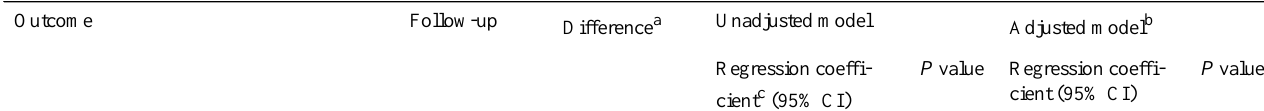
Table 3. Summary of trial hypotheses analyses at the 3-month follow-up